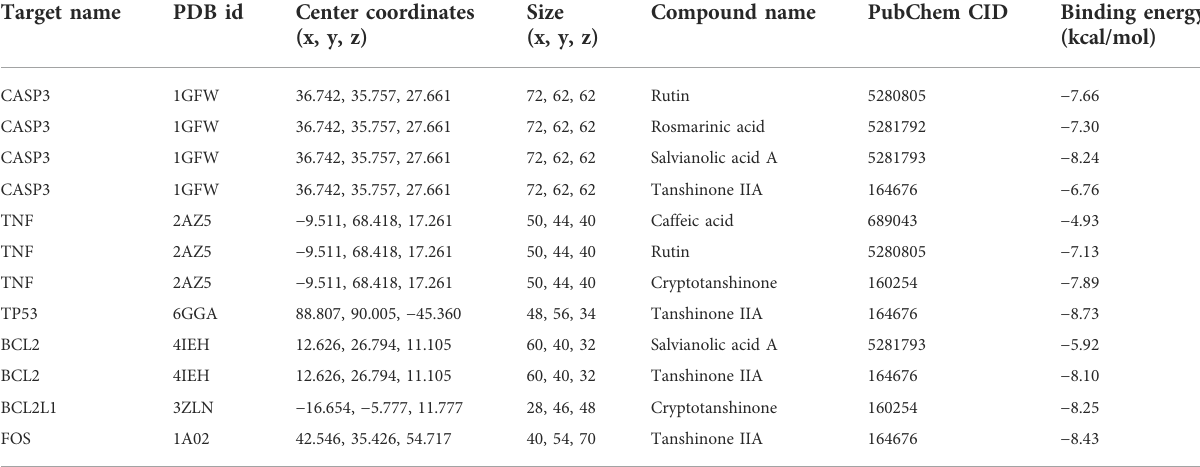
TABLE 3 Docking parameters and results of the active compounds and the corresponding apoptosis pathway-related